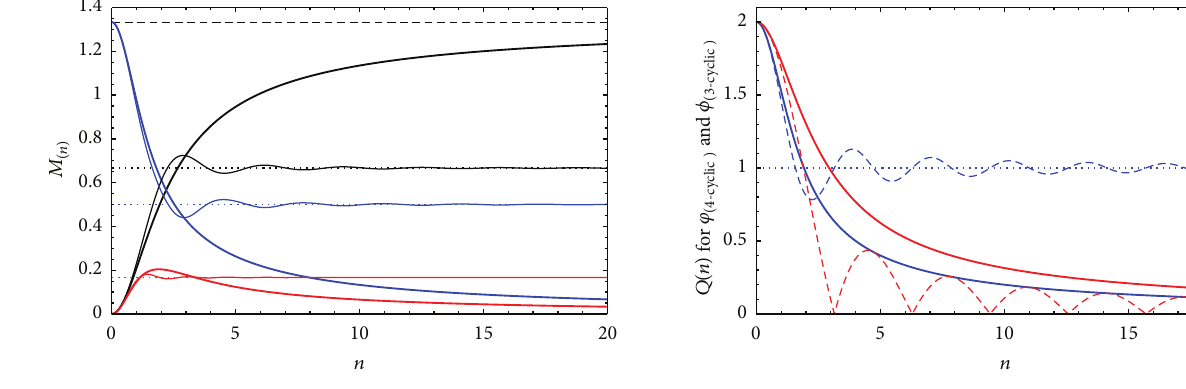
Figure 8: Total energy of localized solutions (topological masses, 𝑛 for hyperbolic (thick lines) and 𝑀 (𝑛) ) as function of the parameter trigonometric (thin lines) 4 -cyclic deformation chains. Results are 𝜑 𝑀 𝜙 𝑀 𝜓 for 𝑀 (𝑛) (blue lines), (𝑛) (red lines), and (𝑛) (black lines). Figure 9: Topological charges, 𝑄 (𝑛) , as function of the parameter 𝑛 for hyperbolic (thick lines) and trigonometric (dashed lines) deformation chains. Results are for the kink-like solutions obtained from 4 -cyclic (blue lines) and 3 -cyclic (red lines) deformation and the topological masses are given by chains, respectively, related to 𝜑 (𝑛) and 𝜙 (𝑛)